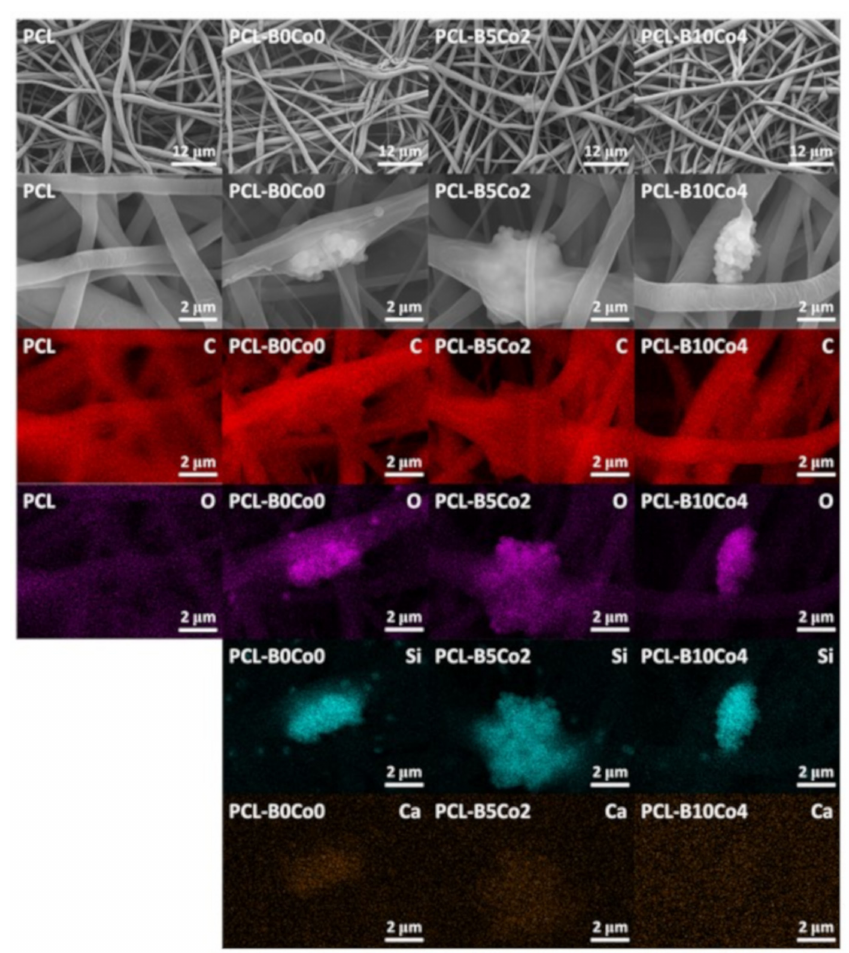
Figure 4. SEM micrographs and energy-dispersive X-ray spectroscopy (EDX) element maps of PCL-BCo.BGNs mats. Table 3. Average fiber diameter (compared with PCL: 0.01 < *P < 0.05, 0.001 < **P < 0.01, ***P < 0.001, mean ± standard deviation (SD), N = 180), minimum and maximum fiber diameter and Young’s modulus (compared with PCL: 0.01 < *P < 0.05, 0.001 < **P < 0.01, ***P < 0.001, mean ± SD, N =